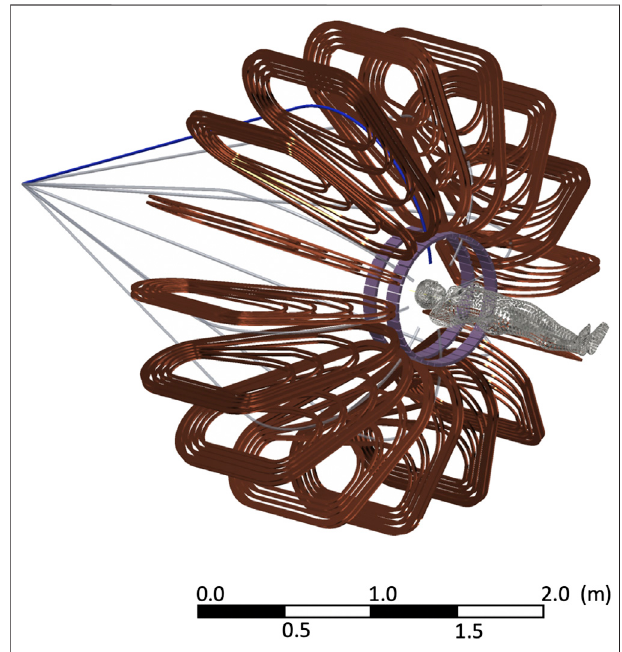
FIGURE 1 | Representation of the GaToroid coil con fi guration for the beam delivery together with two PET rings used for the range monitoring simulations (case 1 in the following). The shape of the patient is used for size comparison. The beam lines start diverging after the vector magnet, that directs them toward the GaToroid with the appropriate